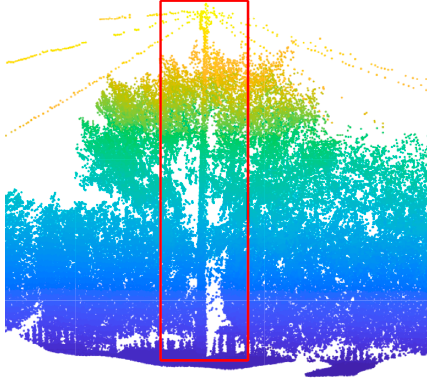
Figure 14. Undetected utility pole that is surrounded by the canopy. Figure 13. Results of PLO recognition in Data I. Different colors represent the different class. Figure 15. Undetected utility pole that is surrounded by the canopy.